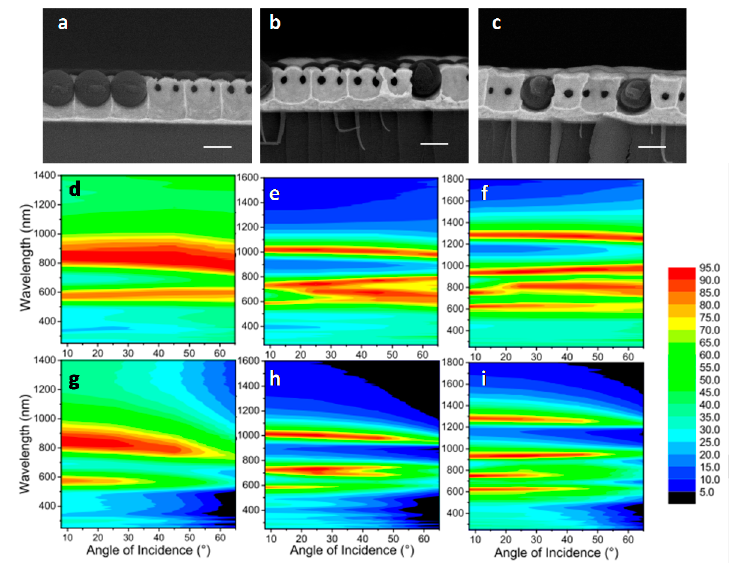
Figure 12. ( a – c ) Cross section SEM images of increasing amounts of gold electrodeposited into a monolayer of polystyrene beads with a diameter D. Scale bars are 300 nm. ( d – i ) Incidence-angle dependent absorption of gold films containing a monolayer polystyrene beads under ( d – f ) p- and ( g – i ) s-polarized incident light. D = 260 nm ( d,g ); 460 nm ( e,h ); and 595 nm ( f,i ) [97].